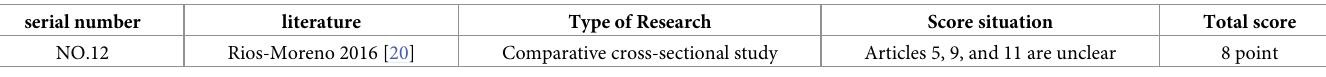
Table 3. AHRQ cross-sectional study evaluation standard